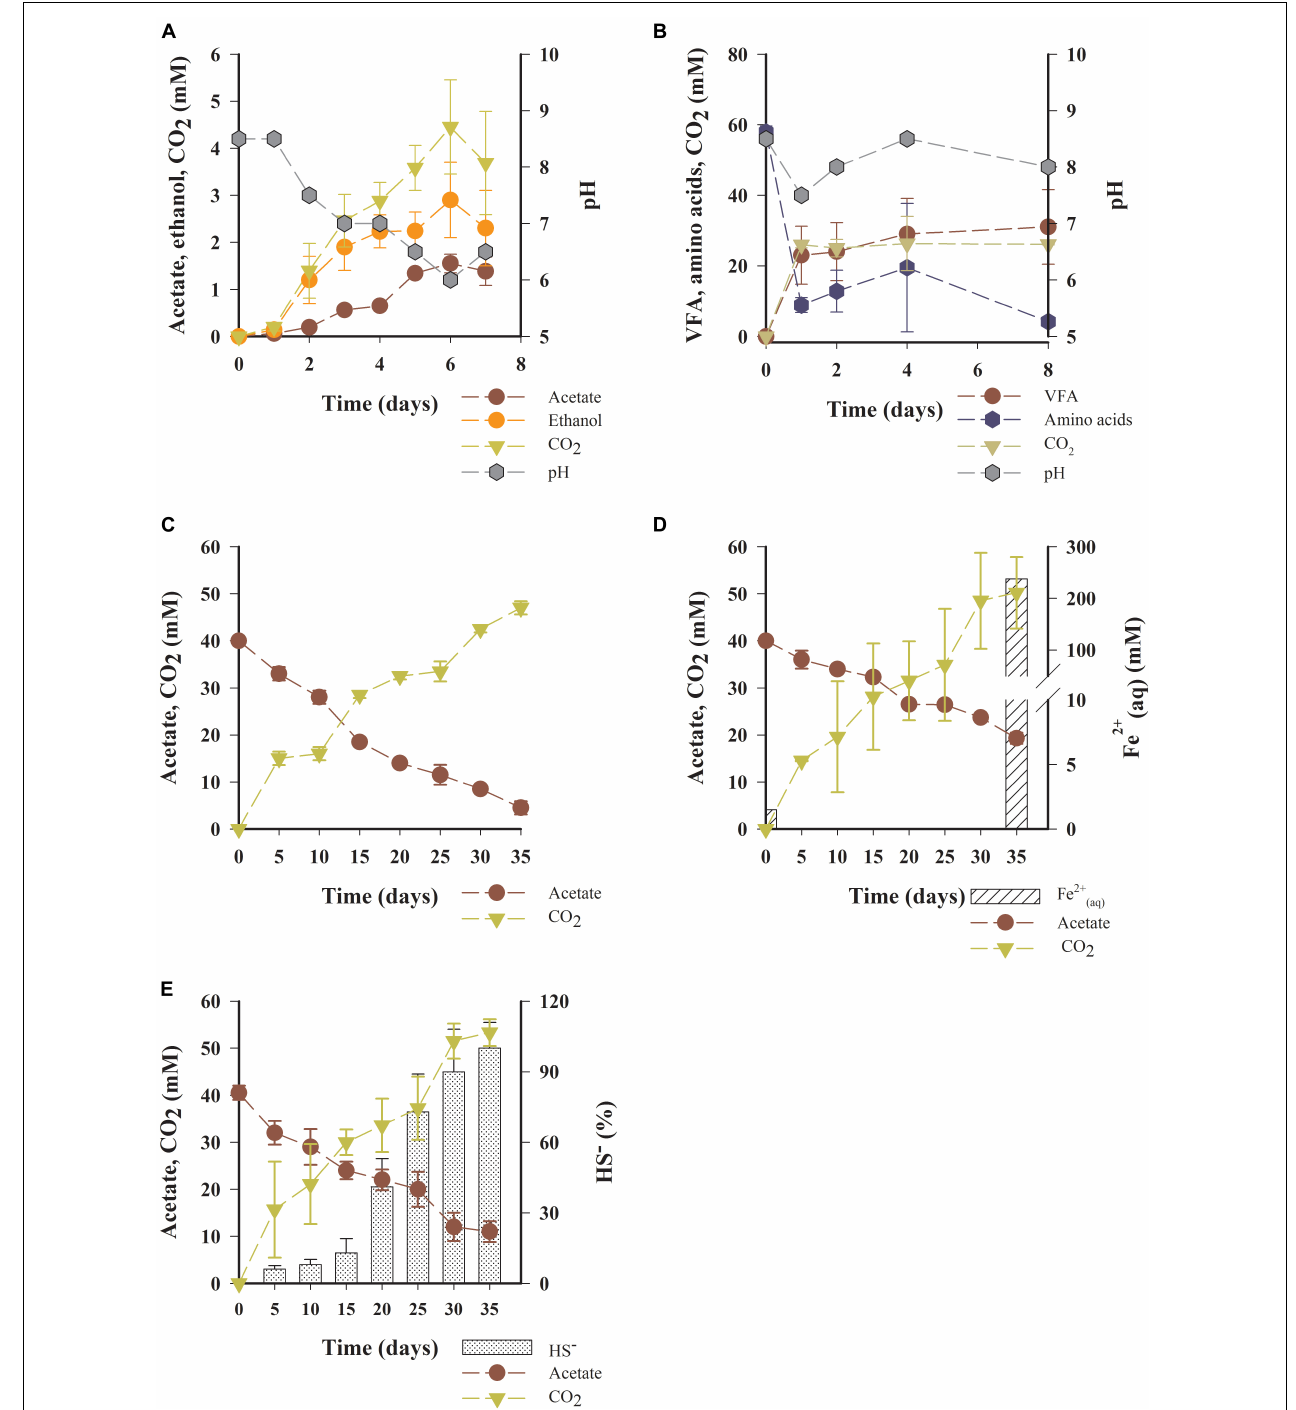
FIGURE 2 | Fermentation of glucose and amino acids during incubations. (A) Changes in concentration of acetate, ethanol, CO 2 , and H + (measured as pH) during fermentation of glucose, (B) Decay of amino acid mixed substrate (alanine, leucine, threonine, phenylalanine, ornithine, glutamic acid), and changes in concentration of VFA (sum of acetate, propionate, isobutyrate, butyrate, isovalerate, and valerate), CO 2 and H + during amino acid fermentation. Anaerobic terminal oxidation of acetate. The decay of acetate and increase in concentration of CO 2 , Fe 2 + aq and HS − under induced conditions of (C) denitrification (excess NO 3 − , 60 mM), (D) dissimilative iron reduction [excess Fe(OH) 3 , 250 mM], and (E) dissimilative sulfate reduction (excess SO 42 − , 50 mM). Values shown represent the average ± standard deviation. Relative abundance of HS − is shown as percent of maximum production.